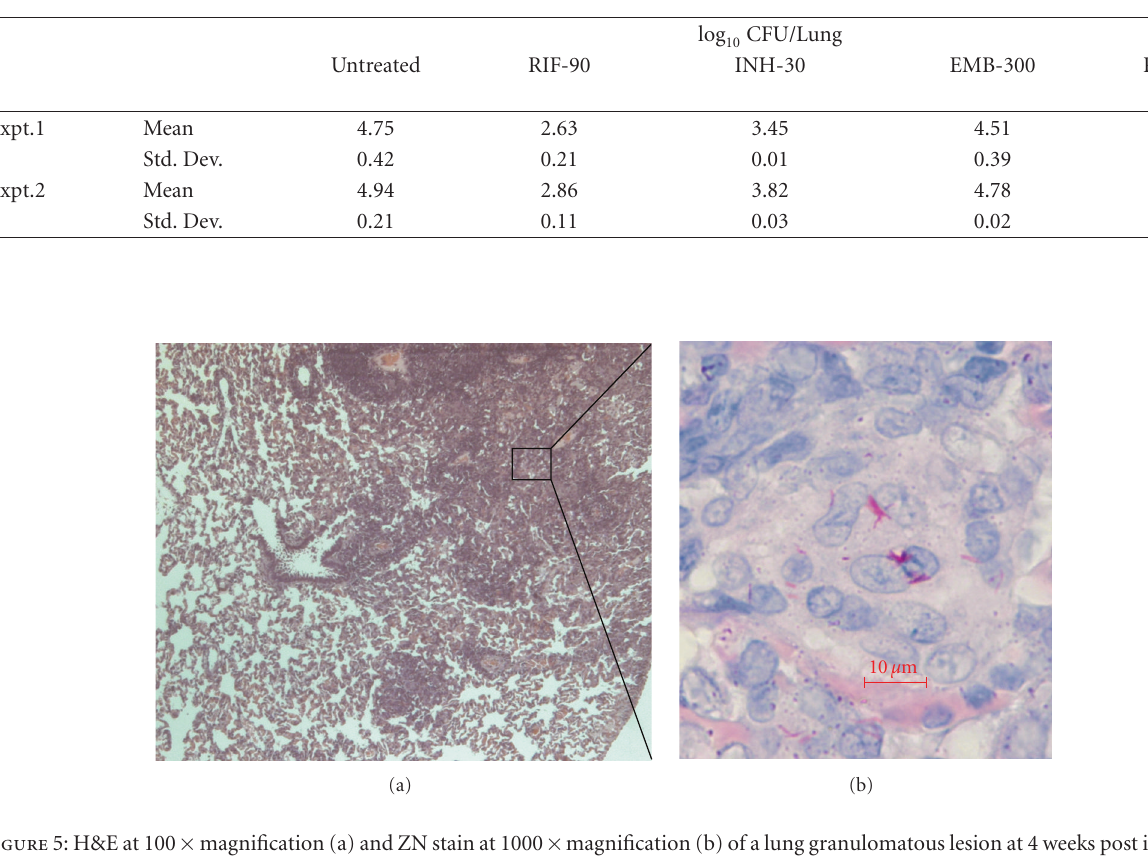
Table 1: Reproducibility of infection and response to treatment across 2 independent experiments. Each data point represents the mean ± SD data from three animals per group.